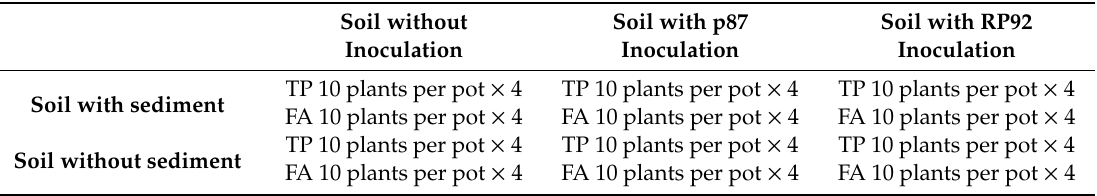
Table 1. Experimental model (TP— Tagetes patula ; FA— Festuca arundinacea ; p87— Massilia niastensis p87 strain; RP92— Streptomyces costaricanus RP92